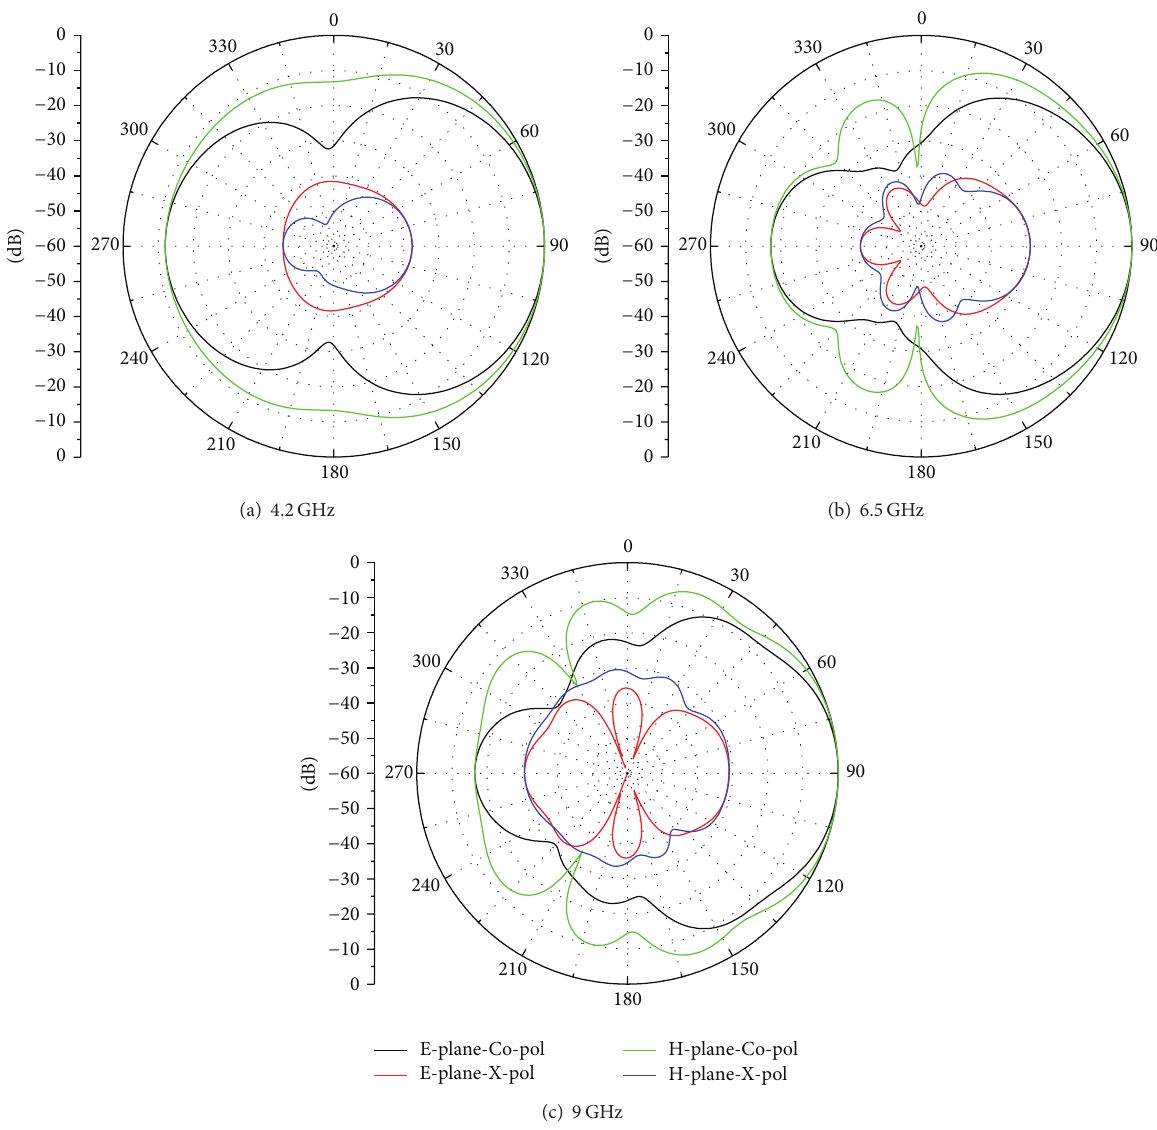
Figure 3: Simulation results of radiation